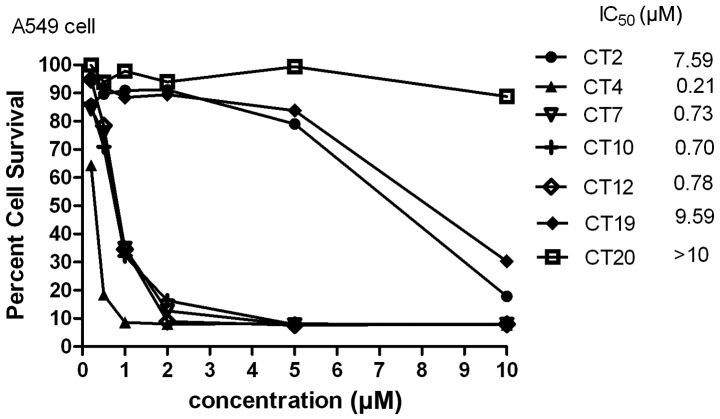
Survival index curves of CT2, CT4, CT7, CT10, CT12, CT19 and CT20 at six different concentrations in the human cancer cell line A549. Each point represents the mean ± standard error, calculated using nonlinear regression in GraphPad Prism.